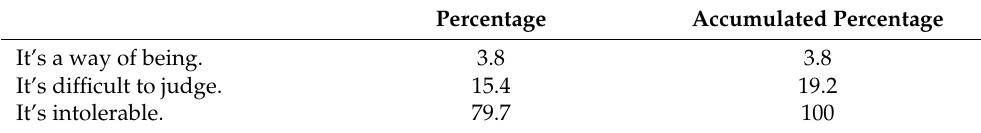
Table 2. Judgment distribution toward verbal, psychological, or physical violence. Percentage Accumulated Percentage It’s a way of being.